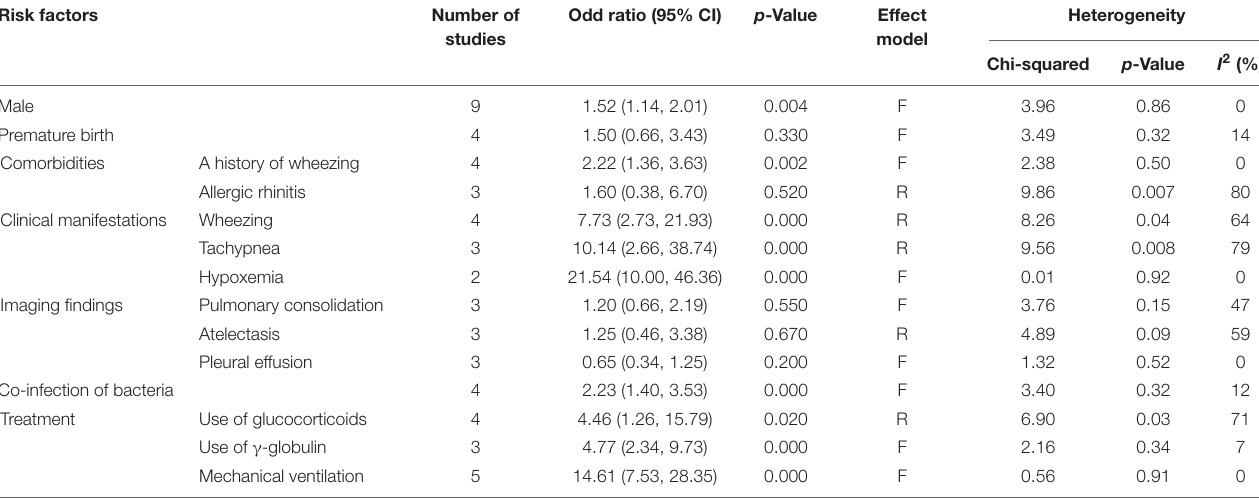
TABLE 2 | Summary of risk factors for post-infectious bronchiolitis obliterans (PIBO).